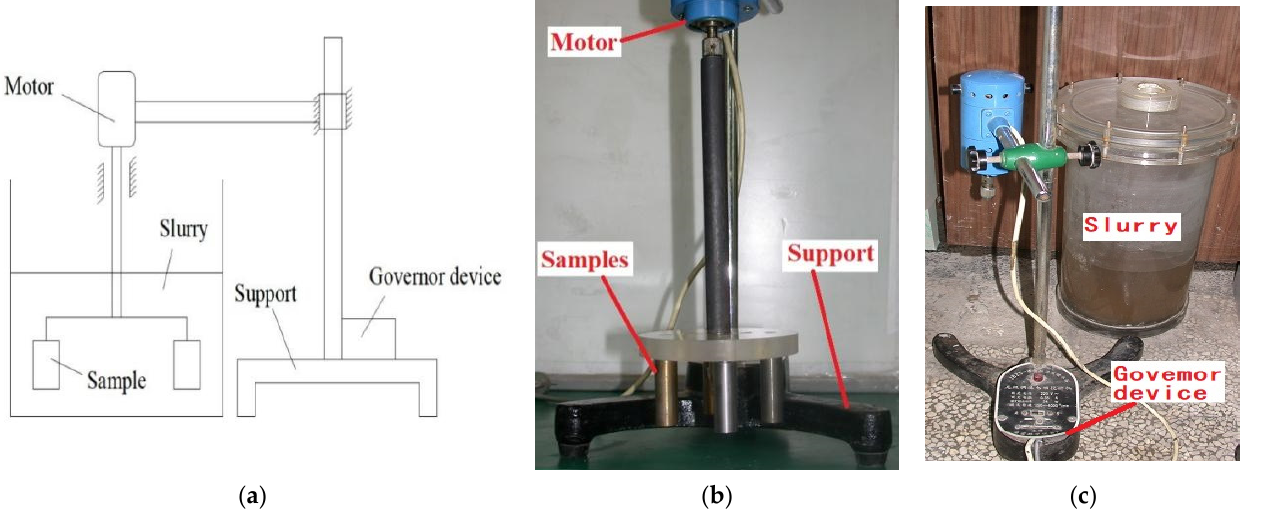
Figure 2. ( a ): Schematic diagram, ( b , c ): corresponding components of the testing corrosion-erosion setup